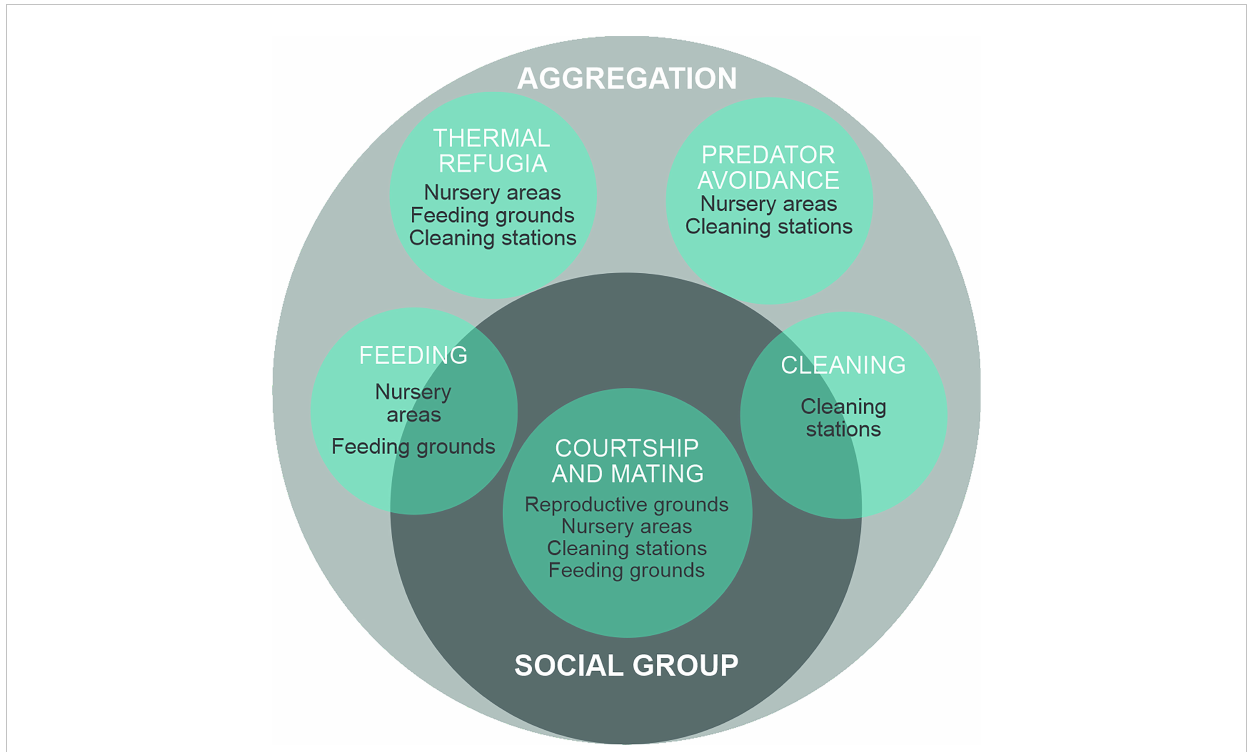
FIGURE 1 Conceptual framework of grouping behaviors in elasmobranchs. Aggregation (individuals are passively drawn together) is the general term to describe any group and the fi rst prerequisite for the formation of social groups (individuals are drawn to one another). Life history functions (in white italics) acting as drivers of manta and devil ray aggregations. In grey are the key aggregation sites where these life history fuctions